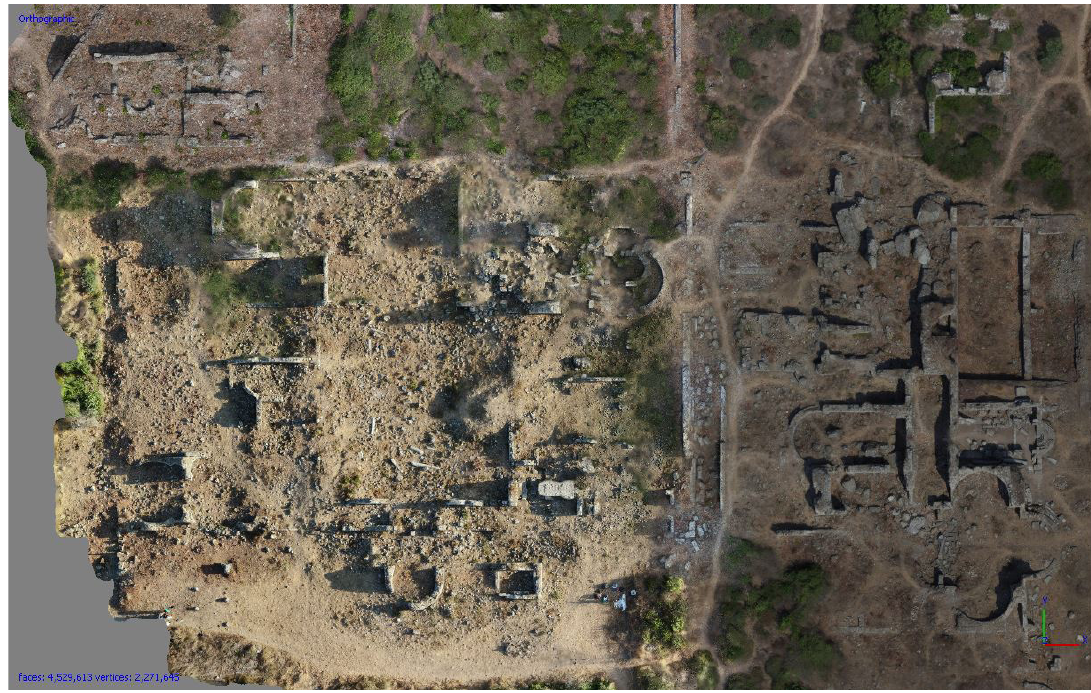
Figure 9.3. Textured model view (© M. Hernández Cordero).